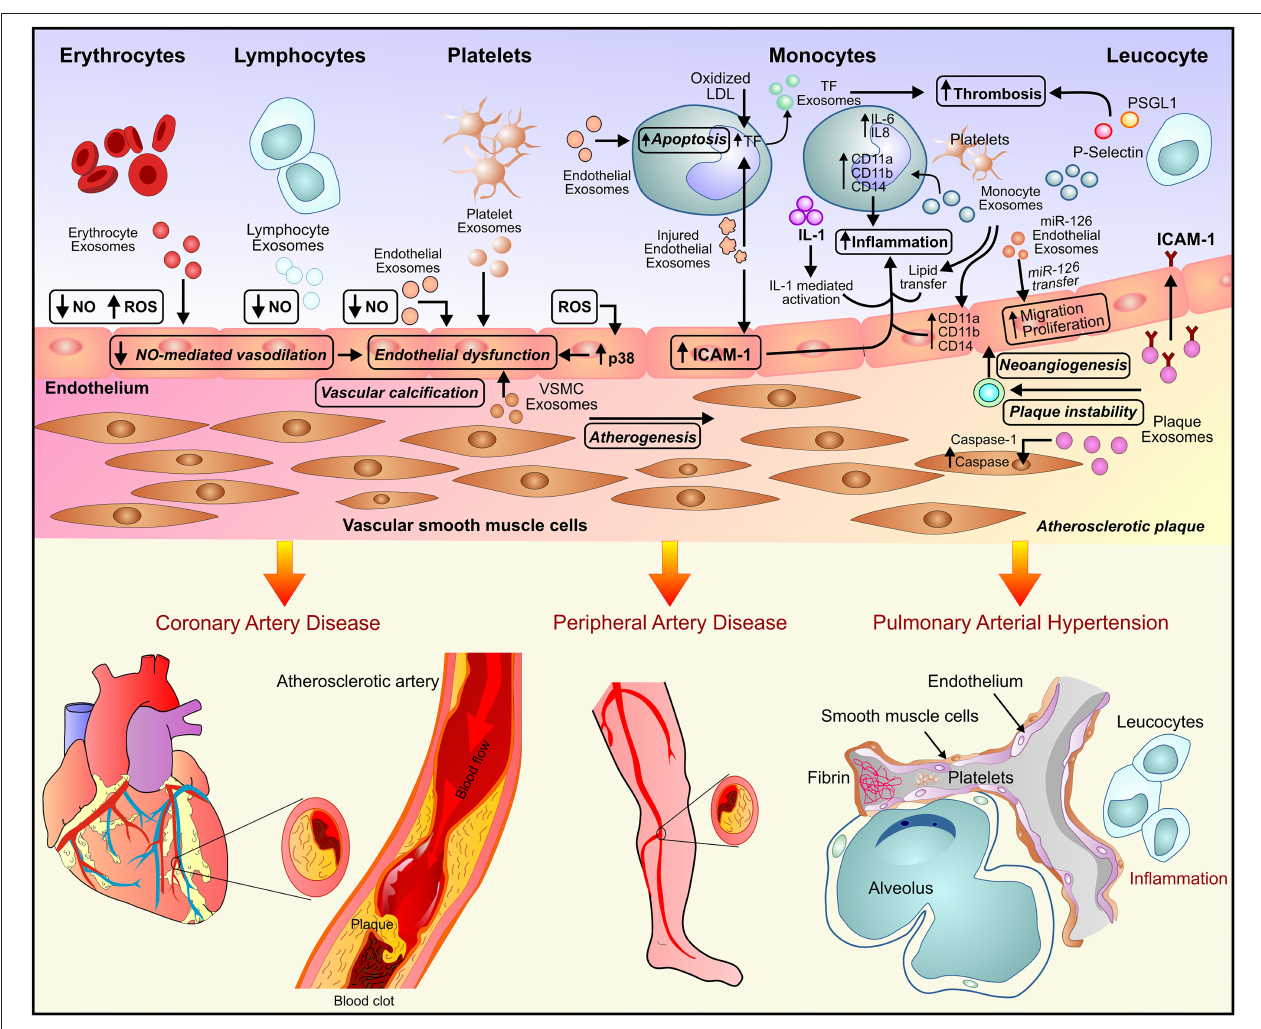
FIGURE 1 | Exosome-mediated paracrine signaling and development of vascular diseases. Exosome secreted by endothelial cells, inflammatory cells, and the myriad of circulating blood cells leads to endothelial dysfunction and inflammation and subsequently, the development of vascular diseases such as atherosclerosis, peripheral artery disease, and pulmonary arterial